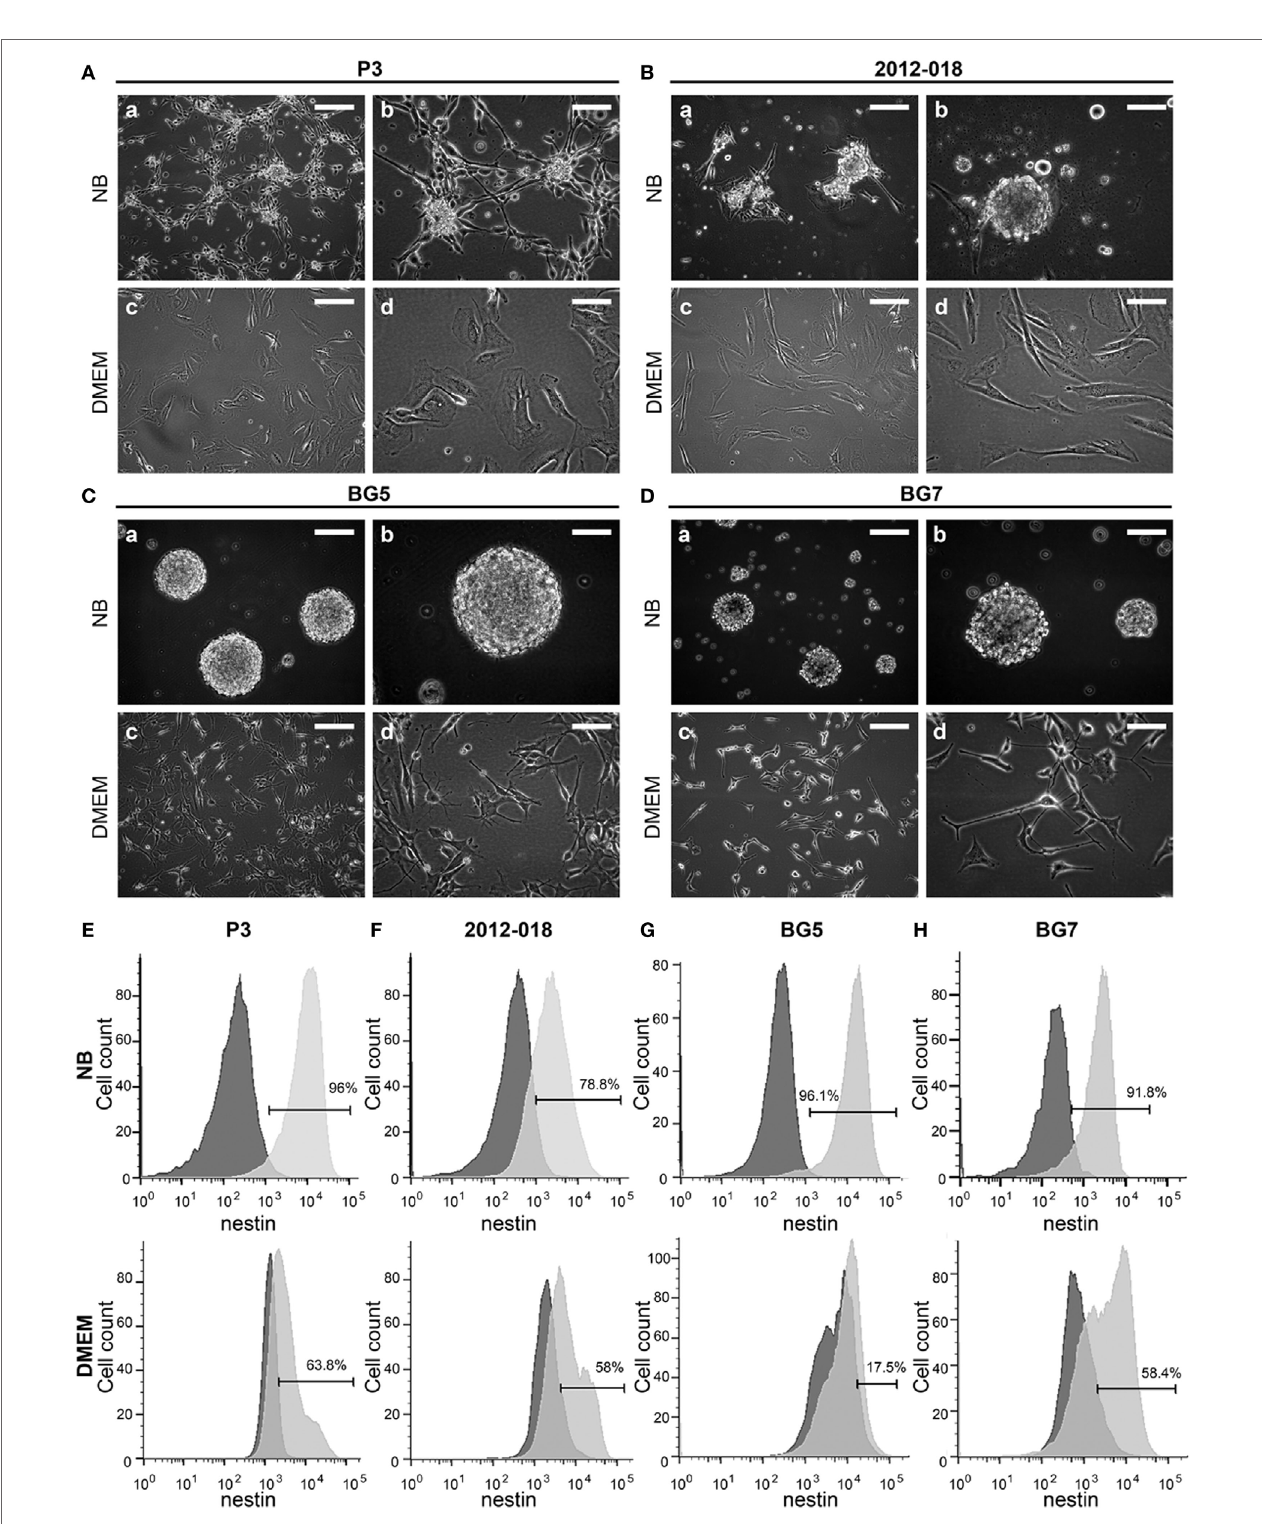
FigUre 1 | Culture medium impacts patient-derived glioblastoma (GBM) cells’ morphology and phenotype. Cell morphology of (a) P3, (B) 2012-018, (c) BG5, and (D) BG7 GBM cells cultured in NB (a) magnification 100 × , scale bar 50 µm, (b) magnification 200 × , scale bar 50 µm; and in Dulbecco’s modified eagle medium (DMEM) (c) magnification 100 × , scale bar 50 µm, (d) magnification 200 × , scale bar 50 µm. Histograms showing intracellular expression of nestin on (e) P3, (F) 2012-018, (g) BG5, and (h) BG7 GBM cells cultured in NB (upper histograms) and in DMEM (lower histograms). Dark gray histograms—fluorescent minus one control and light gray histogram—nestin.